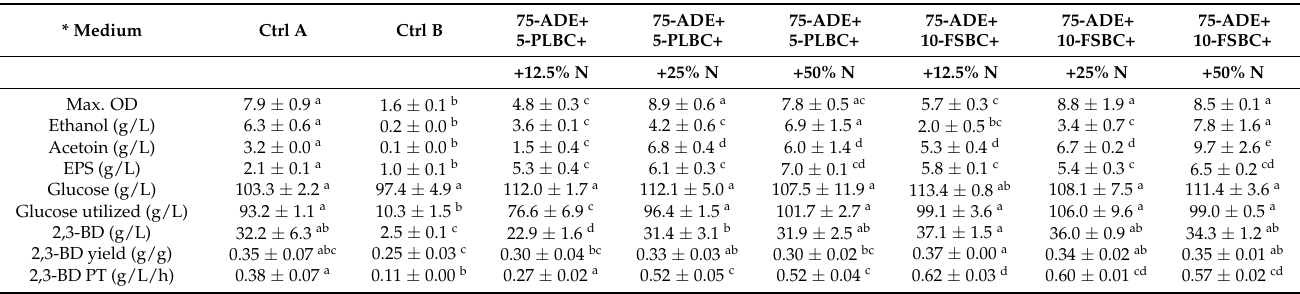
Table 7. Fermentation parameters of P. polymyxa grown in Group D media containing ~115 g/L glucose supplemented with ADE, organic nitrogen, and poultry liter biochar (PLBC) or forage sorghum biochar (FSBC).